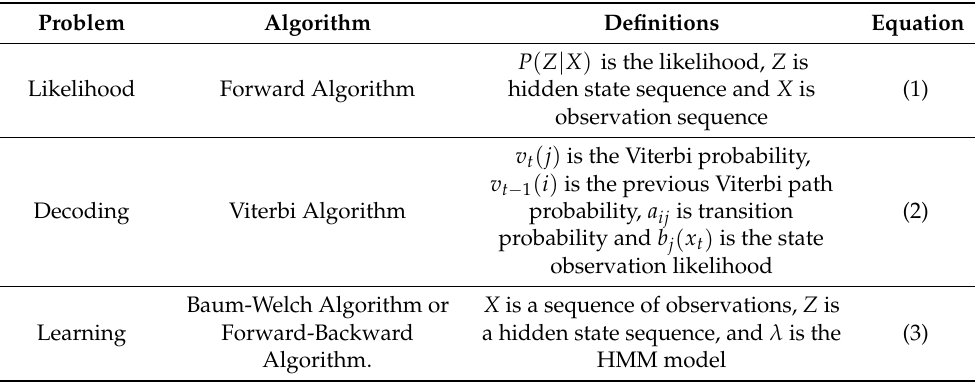
Table 3. Problems and Algorithms of HMM.